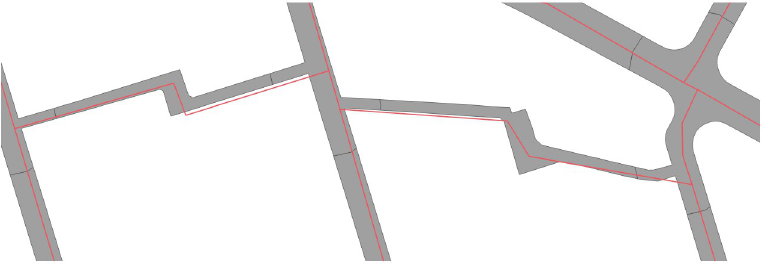
Fig 5. Example of an imperfect overlap between the areal and linear datasets in Pozna ń . Centrelines and polygons sometimes only partially overlap. This does not affect the road width calculation, as the closest perpendicular lines will be used regardless of the centreline’s overlap with the